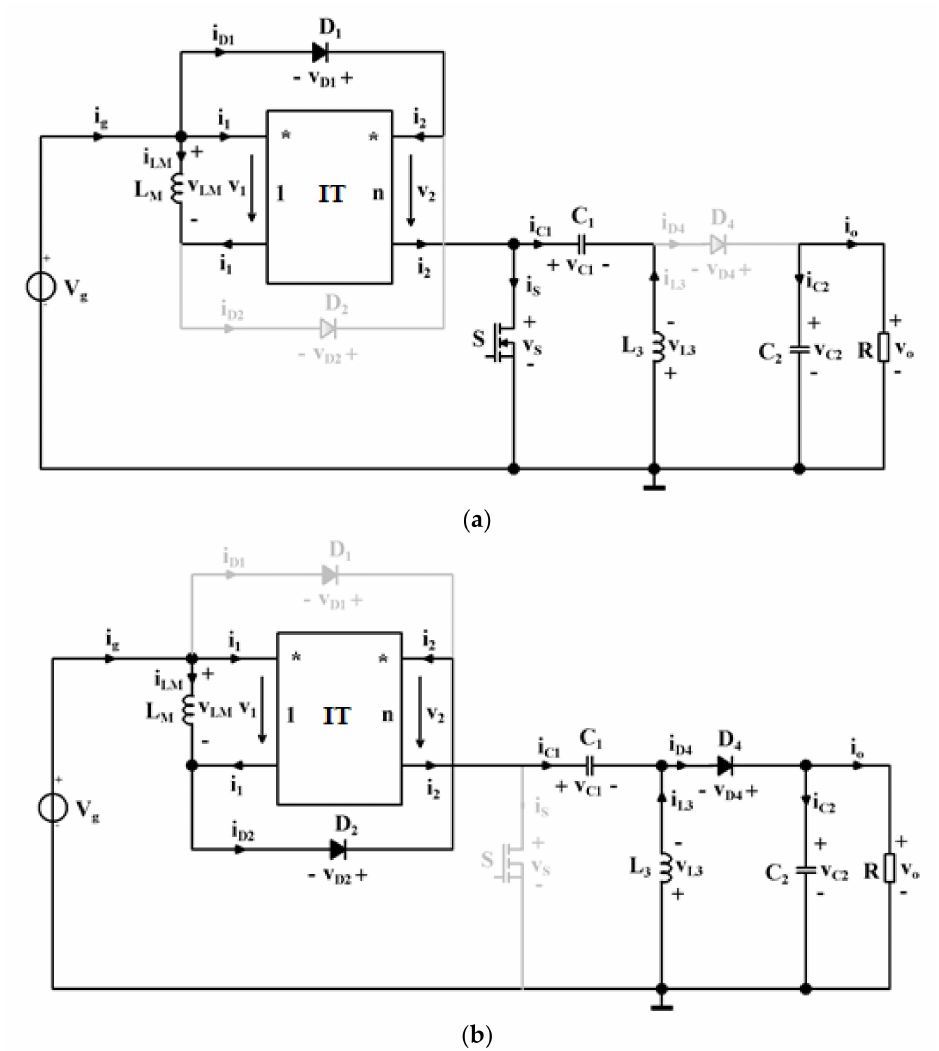
Figure 4. The equivalent circuits of the proposed hybrid SEPIC-based dc-dc converter with coupled inductors in CCM: ( a ) first topological state; ( b ) second topological